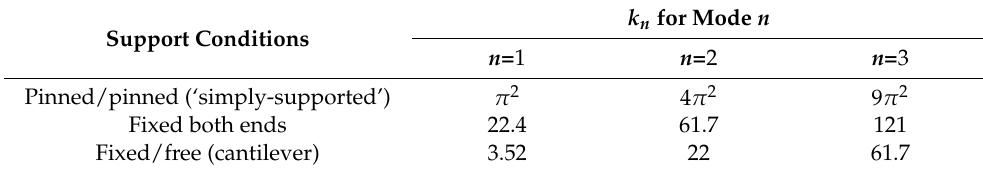
Table 1. k n Coefficients for Uniform